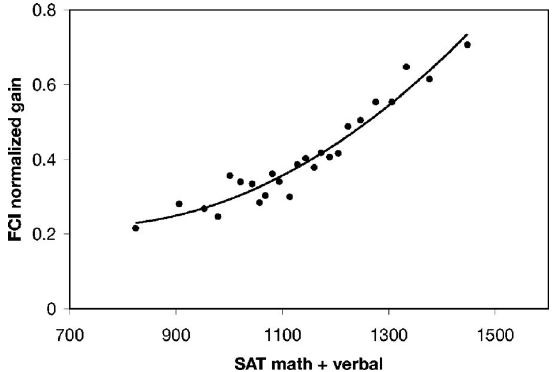
FIG. 3. Plot of normalized gains versus SAT scores for 627 LMU and ELHS students, with individual student data averaged within 25 bins.